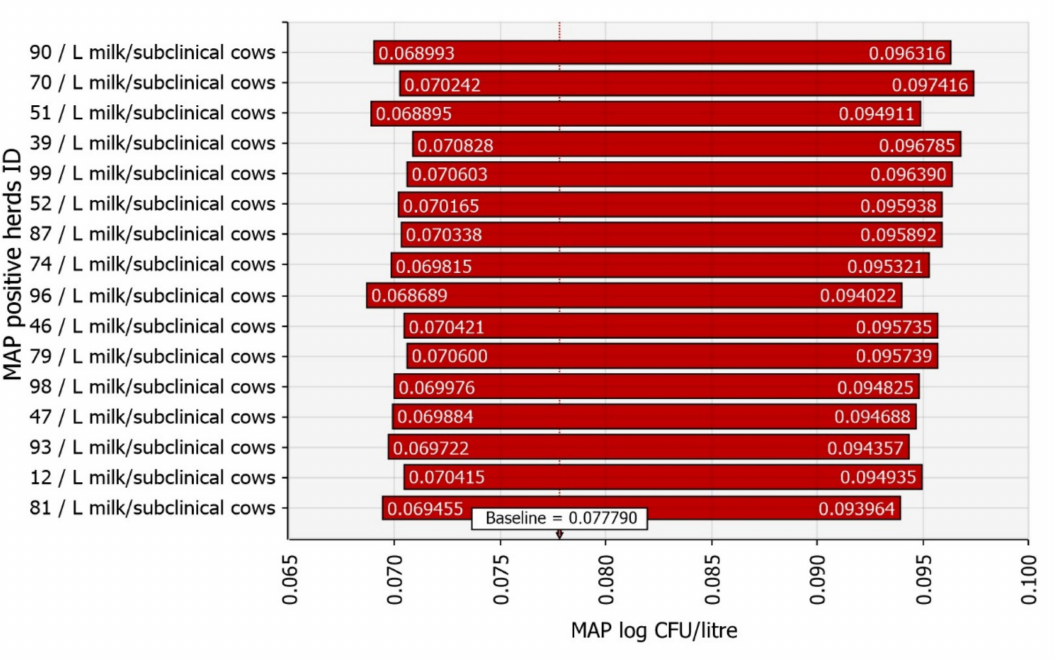
Figure 7. Input variables ranked by the effect on the mean Mycobacterium avium subsp. paratuberculosis (MAP) contamination of silo milk in scenario 1. The numbers on the y -axis indicate the sequential number of simulated dairy herds. In addition, we tested the influence of small herd size threshold values on the model results. We tested four different threshold values based on the proportion of small herds. Specifically, 79.8% of all herds in Slovenia have a maximum of 25 cows, 90% have a maximum of 36 cows, 98.4% have a maximum of 75 cows and 99.3% of all herds have a maximum of 100 cows in a dairy herd. The results are shown in Table 3 with the mean, 5th and 95th PC for milk contamination and human exposure with the proportion of MAP positive litres of milk. In general, lower threshold values resulted in higher contamination of milk with MAP and slightly higher human exposure at the farm level. However, they did not affect the risk of human exposure to MAP via retail